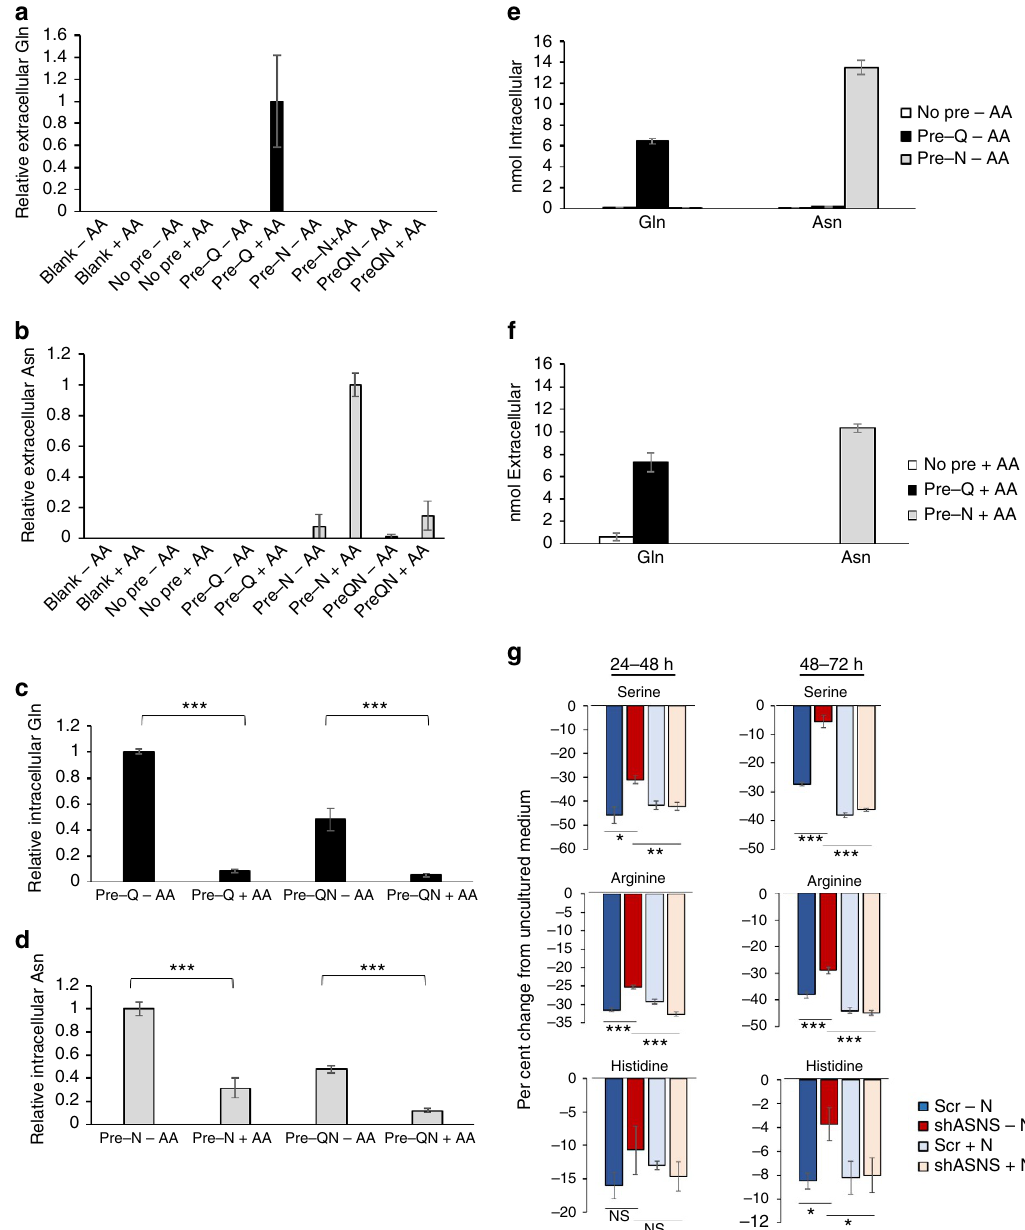
Figure 3 | Asparagine is an amino acid exchange factor. Relative glutamine ( a ) and asparagine ( b ) levels in the medium from LPS2 cells, as measured by LC-MS, before and after amino acid (AA) stimulation following pre-loading of the cells with glutamine (Q) and/or asparagine (N). Serum- and amino acid-starved LPS2 cells were pre-loaded with 2mM glutamine, 2mM asparagine or 2mM glutamine and 2mM asparagine for 60min prior to stimulation for 30min with an amino acid mixture (AA medium) lacking glutamine and asparagine. ‘Blank’ indicates measurements from plates lacking cells. ‘No Pre’ indicates measurements from plates of LPS2 cells not pre-loaded with glutamine or asparagine. Relative intracellular glutamine ( c ) and asparagine ( d ) levels as measured by LC-MS in glutamine- and/or asparagine-pre-loaded cells before and after amino acid stimulation. ( e ) Absolute quantification of intracellular glutamine and asparagine in pre-loaded cells prior to amino acid stimulation. ( f ) Absolute quantification of extracellular glutamine and asparagine following amino acid stimulation. ( g ) Changes in extracellular amino acid levels during a 24-h incubation with HeLa cells. The 24-h incubation began either 24h (left panels) or 48h (right panels) post doxycycline-induced expression of a scrambled shRNA (Scr) or ASNS shRNA. Values are shown as per cent change from amino acid measurements from identical medium incubated on plates lacking cells, with negative bars indicating cellular consumption and positive bars indicating production. For a – f , error bars denote s.d. of the mean ( n ¼ 3). For g , error bars denote s.e.m. ( n ¼ 6). P values were calculated by the Student’s t -test: * P o 0.05; ** P o 0.01; *** P o 0.001. NS, not